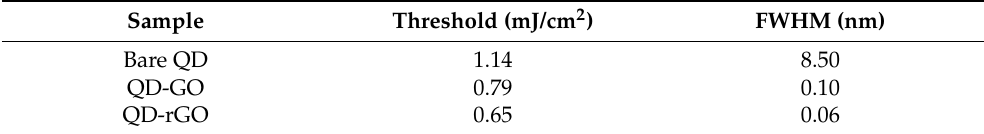
Figure 4. ( a ) Random laser emission spectra of bare QD, ( b ) QD-graphene oxide, and ( c ) QD-reduced- graphene oxide. Table 1. Random laser emission characteristics of different